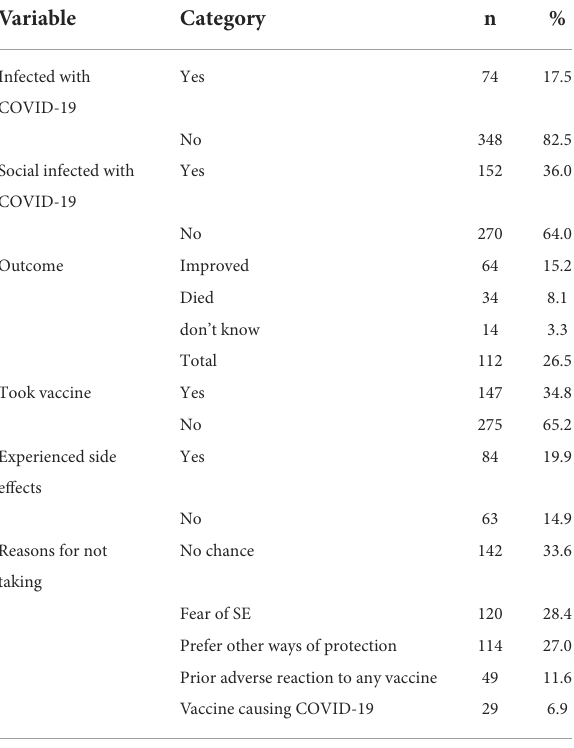
TABLE 4 COVID-19 Preventive Practices of participants at Jimma town 2021, Jimma,